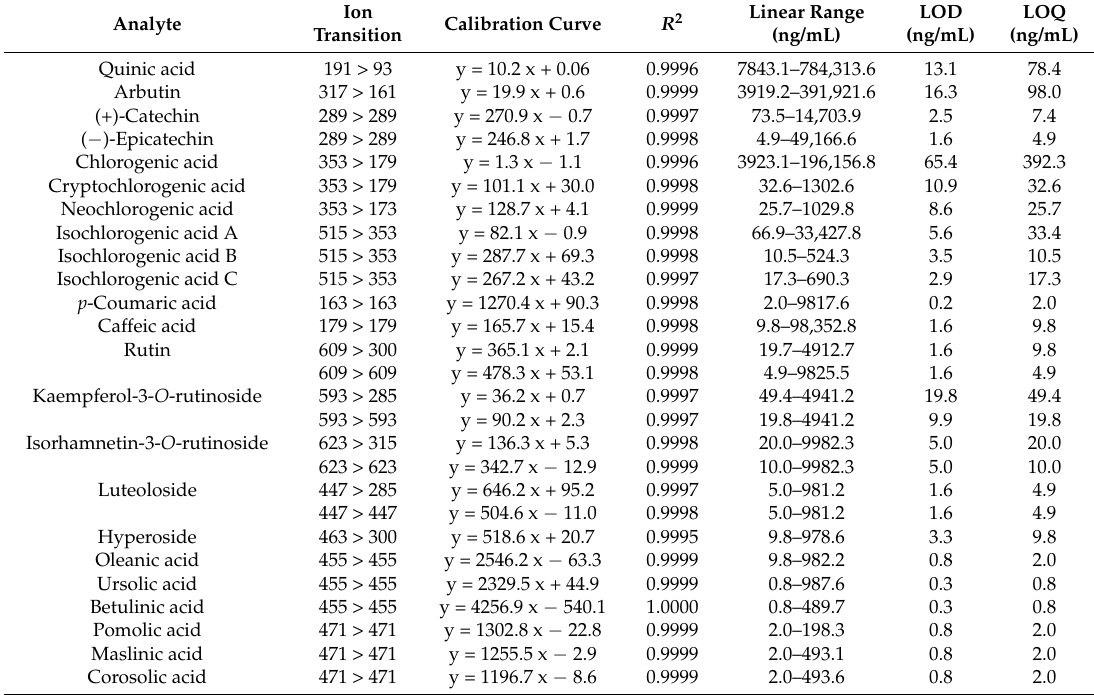
Figure 1. Representative UPLC-MS/MS chromatograms of thinned young pears in the multiple reaction monitoring (MRM) mode. ( A ) the polyphenolic profiles of ‘Hongqieli’ extract, ( B ) the triterpenoid profiles of ‘Yali’ extract. Table 2. Calibration curves, LODs and LOQs data used for UPLC-MS/MS quantification of polyphenols and